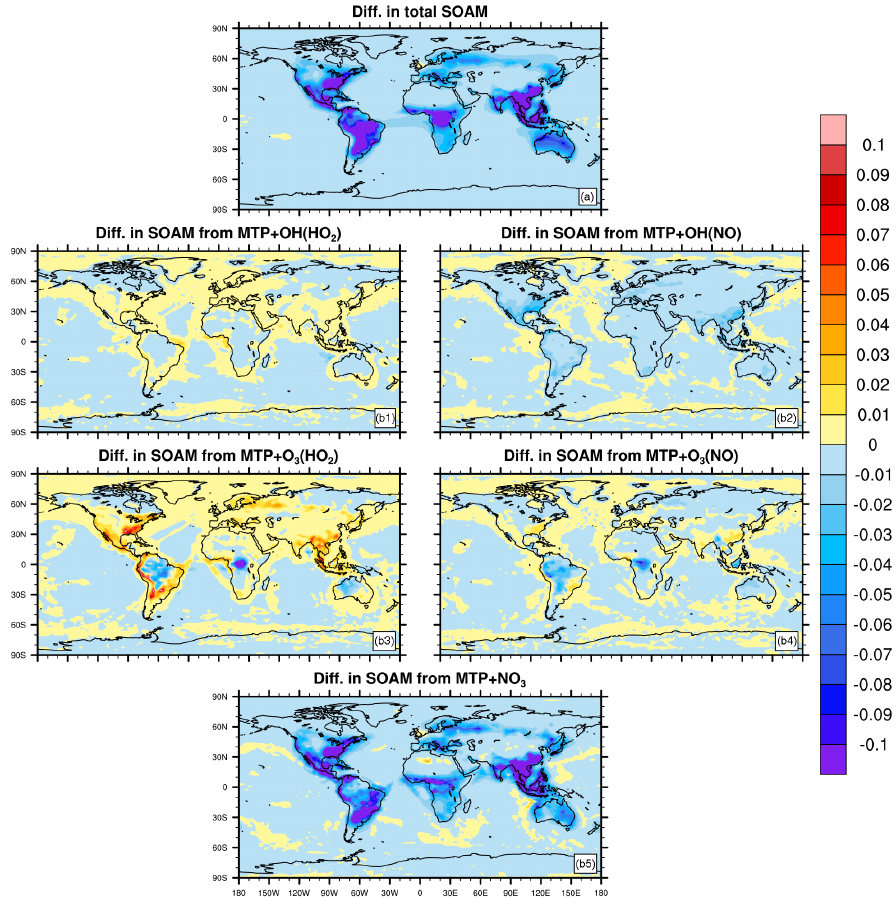
Figure 9. Changes in SOAM concentration (µgm − 3 ) in the sensitivity run with 50% reductions in anthropogenic NO emissions compared to the control run using the VBS_agHigh scheme. The total SOAM change is shown in (a) . The SOAM change in each formation branch is de- noted as (b1) MTP + OH(HO 2 ) (low-NO x OH-photooxidation), (b2) MTP + OH(NO) (high-NO x OH-photooxidation), (b3) MTP + O 3 (HO 2 ) (low-NO x ozonolysis), (b4) MTP + O 3 (NO) (high-NO x ozonolysis), and (b4) MTP + NO 3 (NO 3 -initiated